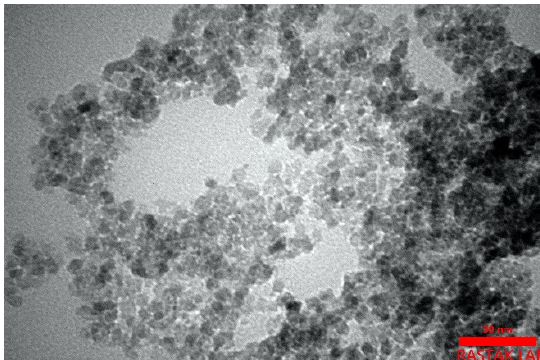
Fig. 5. TEM image of N‐TiO 2 /C; scale bar 50 nm